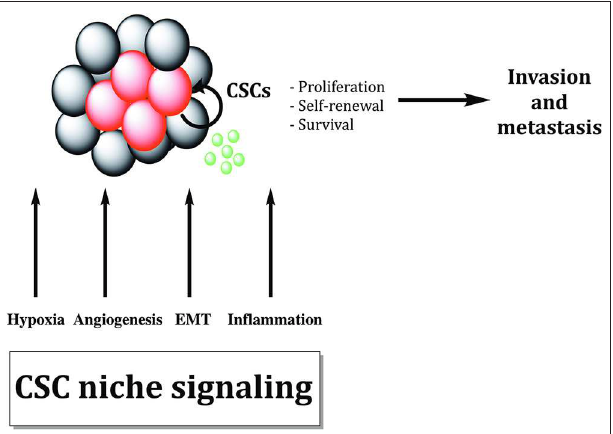
FIGURE 4 | Cancer stem cells are sustained by biological processes within the cancer stem cell niche. Different biological processes like EMT, hypoxia, inflammation, and angiogenesis maintain cancer stem cells (CSCs). Cytokines and growth factors produced by tumor cells and tumor-associated cells increase proliferation and survival of CSCs, promoting tumor invasion and metastasis